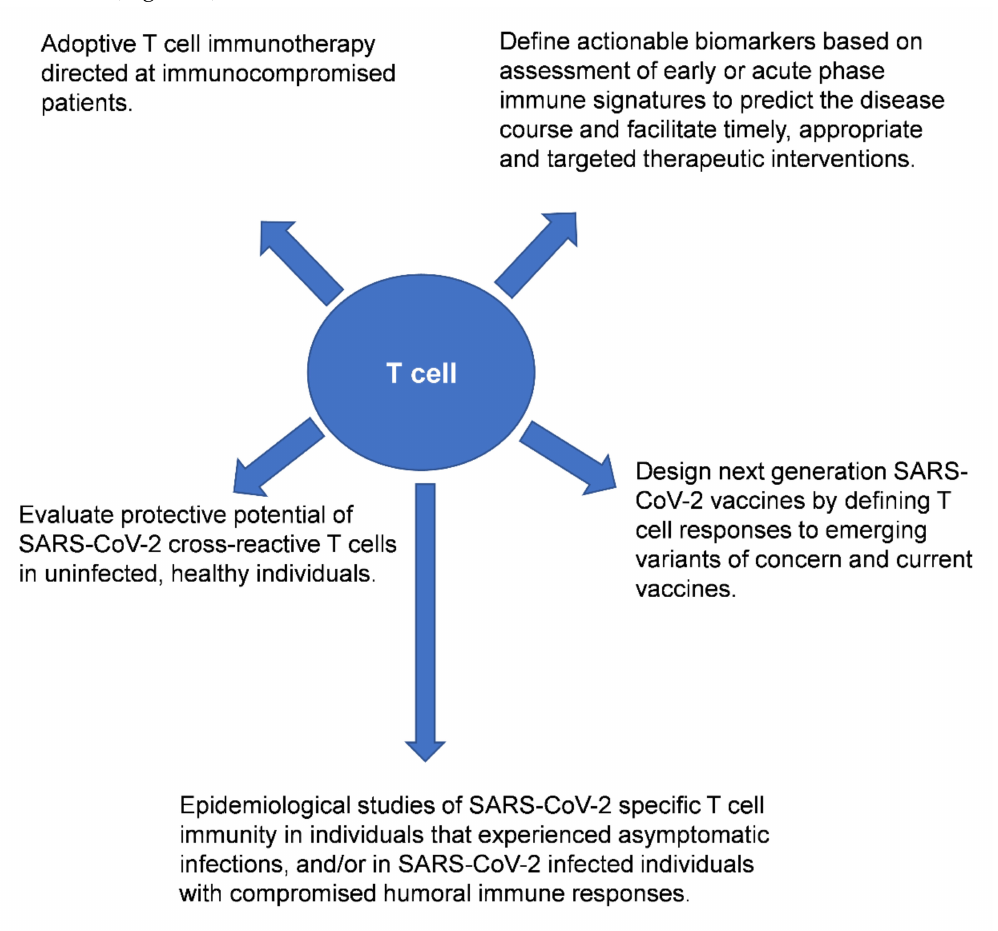
Figure 1. Potential downstream applications of profiling bulk or virus-specific T cells in the context of SARS-CoV-2 infection and/or after COVID-19 vaccination. Reference(s)